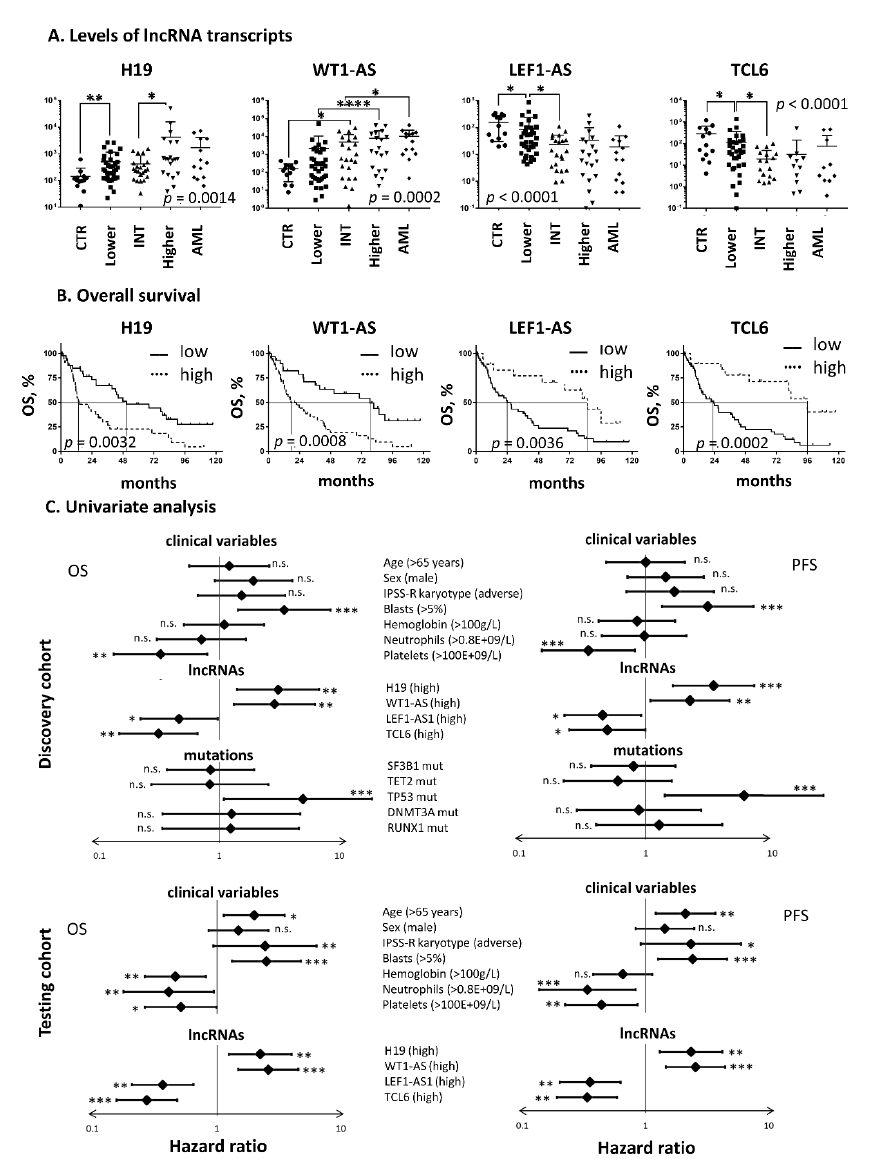
Figure 4. ( A ) Expression of H19, WT1-AS, TCL6, and LEF1-AS lncRNAs in CD34+ BM cells measured by RT-qPCR. The data were logarithmically scaled. The MDS patients (testing cohort) were grouped according to IPSS-R. ( B ) Kaplan-Meier curves for overall survival of MDS patients stratified based on lncRNA levels. ( C ) Forest plots of univariate analysis performed for overall survival (OS) and progression-free survival (PFS) by the log-rank test in both cohorts of MDS patients. Hazard ratios including 95% confidence intervals are plotted and the significance of the results is included (* p < 0.05, ** p < 0.01, *** p < 0.001, **** p < 0.0001, n.s.—nonsignificant). The data from mutational screening were available only for the discovery